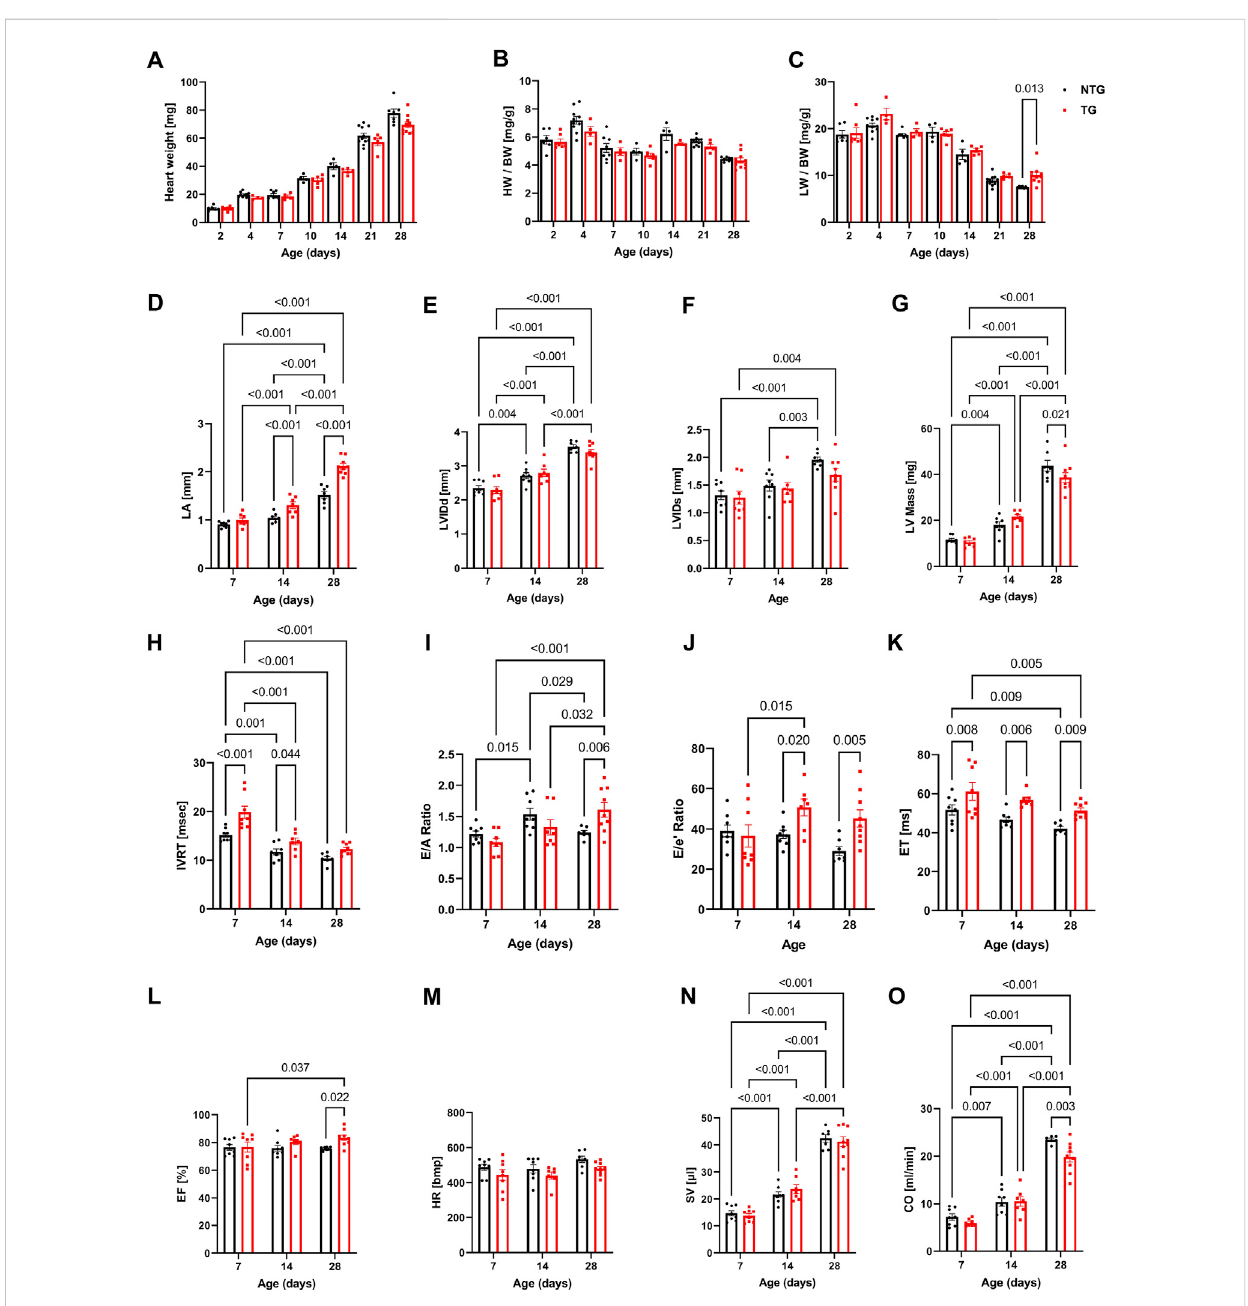
FIGURE 3 Morphological, systolic and diastolic changes in NTG and HCM hearts. Summary data represent: (A) heart weight, (B) heart weight to body weight (HW/BW), (C) lung weight to body weight (LW/BW), (D) left atrial diameter (LA), (E) left ventricular internal diastolic diameter (LVIDd), (F) left ventricular internal systolic diameter (LVIDs), (G) left ventricular mass calculated based on echocardiography (LV Mass), (H) isovolumic relaxation time (IVRT), (I) E/A ratiorepresentspeakvelocityofearlydiastolicmitral fl owdividedbypeakvelocityoflatediastolicmitralin fl ow, (J) E/e ’ ratiorepresentspeakvelocity of early diastolic transmitral fl ow divided by peak velocity of early diastolic mitral annual motion, (K) ejection time (ET), (L) ejection fraction (EF), (M) heart rate (HR), (N) stroke volume (SV), and (O) cardiac output. Data reported as mean ± SEM. N = 4 – 9 for panels (A – D) . N = 6 – 9 for data presented in panels (E – O) . Data were analyzed by 2-way ANOVA followed by Fisher ’ s LSD test; NTG, non-transgenic; TG,